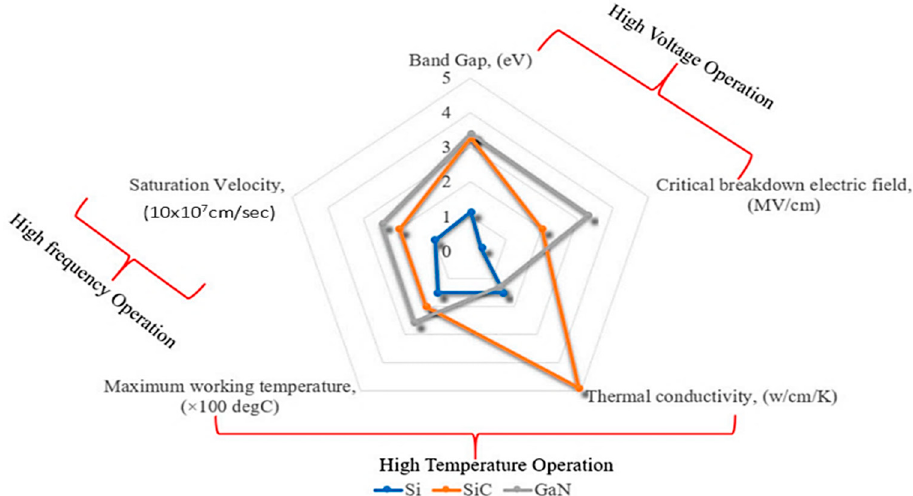
Figure 2. Comparison between silicon (Si), silicon carbide (SiC), and gallium nitride (GaN) [73]. For Si-based OBCs, the switching frequency for MOSFET-based on-board chargers